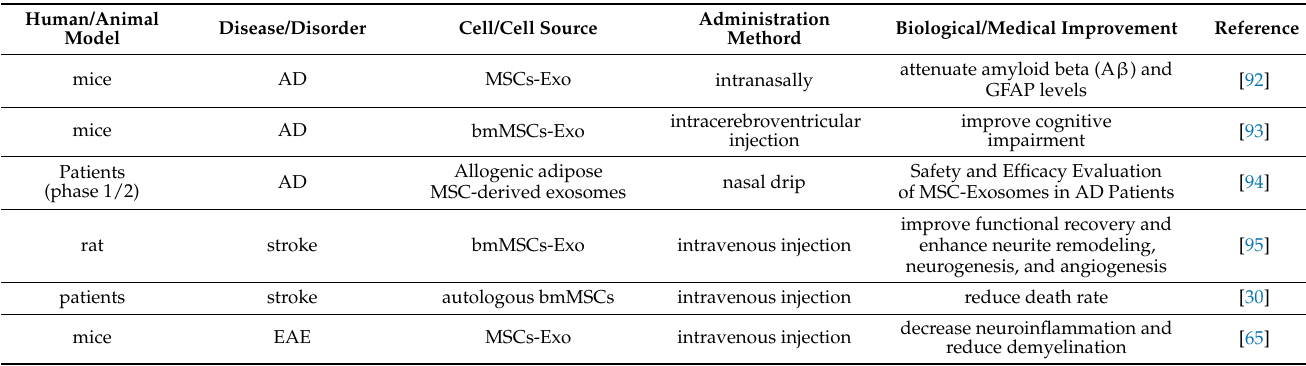
Table 2. Example of MSCs-Exo against neurodegenerative